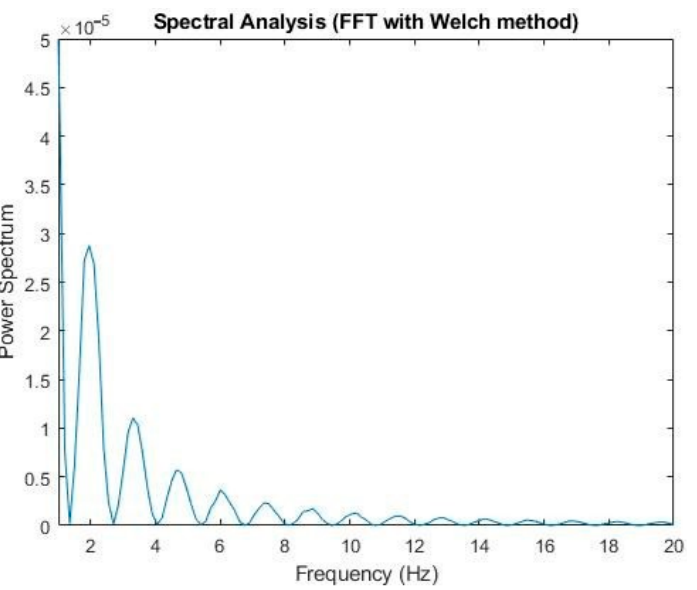
Figure 8. Based on the Fourier transform, Welch method, and Hamming window, the maximum influence spectrum was about 2 Hz to 4